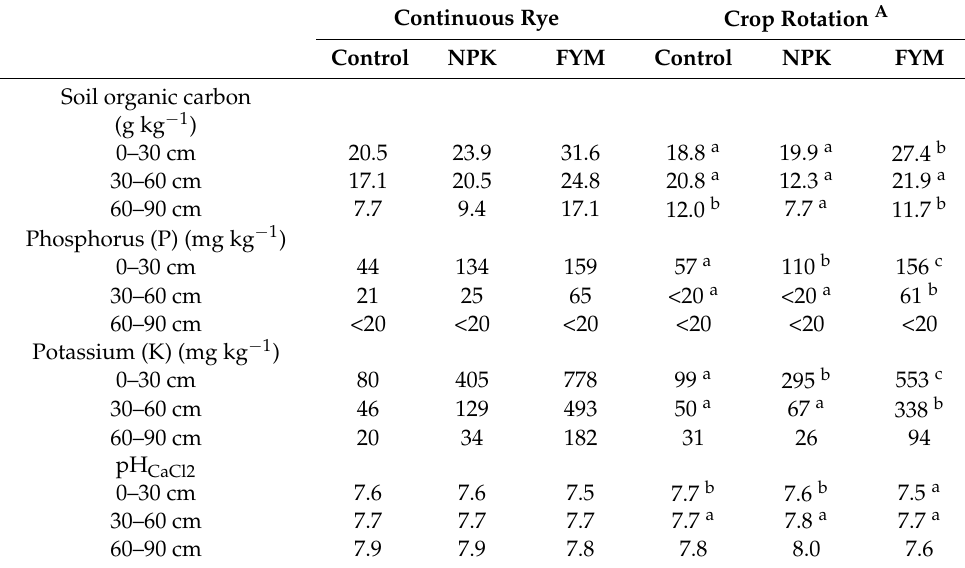
A Mean value of the three plots in the crop rotation. Significant differences between fertilization treatments in each layer are shown with different minor letters ( p < 0.05). NPK = mineral fertilizer; FYM = farmyard manure.